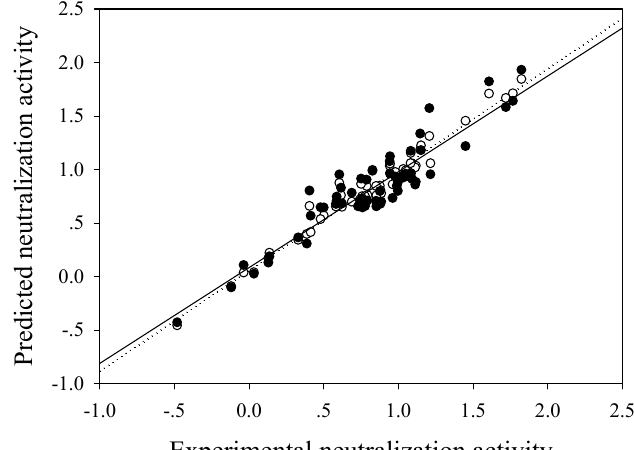
Figure 5. Plot of predicted versus experimental ED 50 for training set ( ○ ; regression line is represented as a dotted line) and leave-one-out cross-validation testing set ( ● ; regression line is represented as a solid line) of